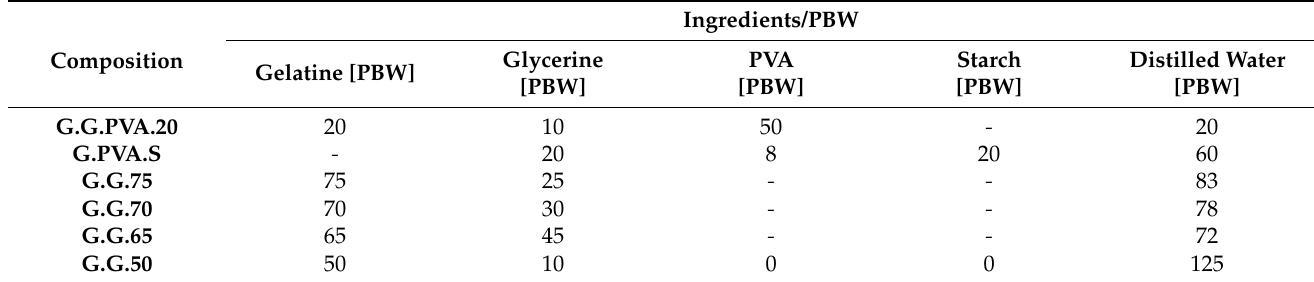
Table 1. Compositions of the matrixes.